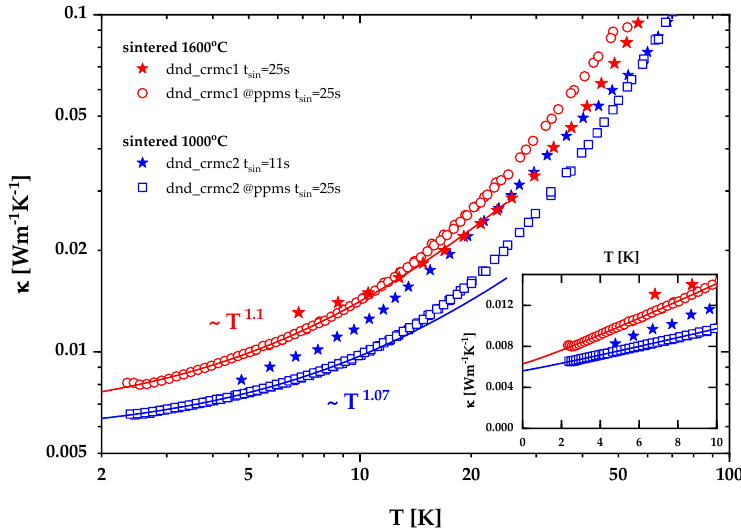
Figure 4. Low temperature thermal conductivity of differently prepared detonated nanodiamond ceramics. Insert : κ(T) data in a linear scale up to 10 K.